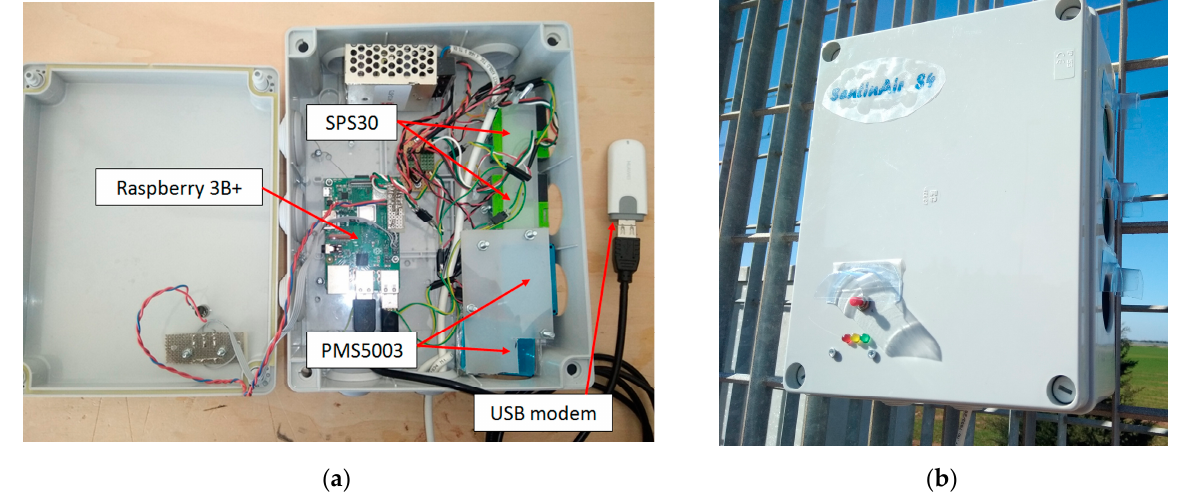
Figure 1. The SentinAir platform: ( a ) the device used in the experiment with the four PM sensors installed inside; ( b ) external view of the device acting as an LCM in this experiment.